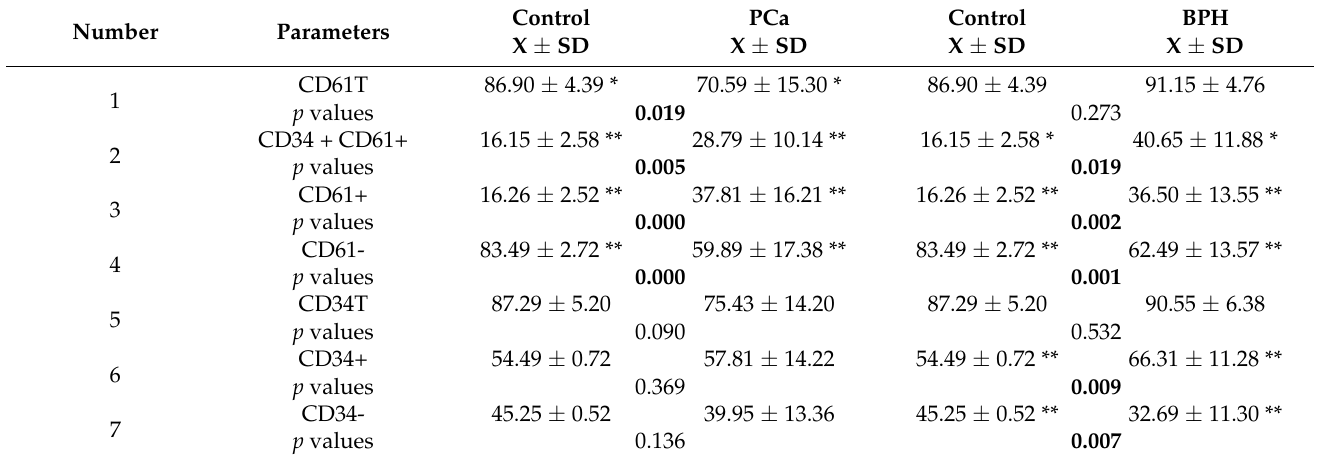
Table 2. CD34 and CD61 glycoprotein expressions implied in cell proliferation in prostate adenocarci- noma, benign prostatic hyperplasia, and non-malignant adjacent tissue